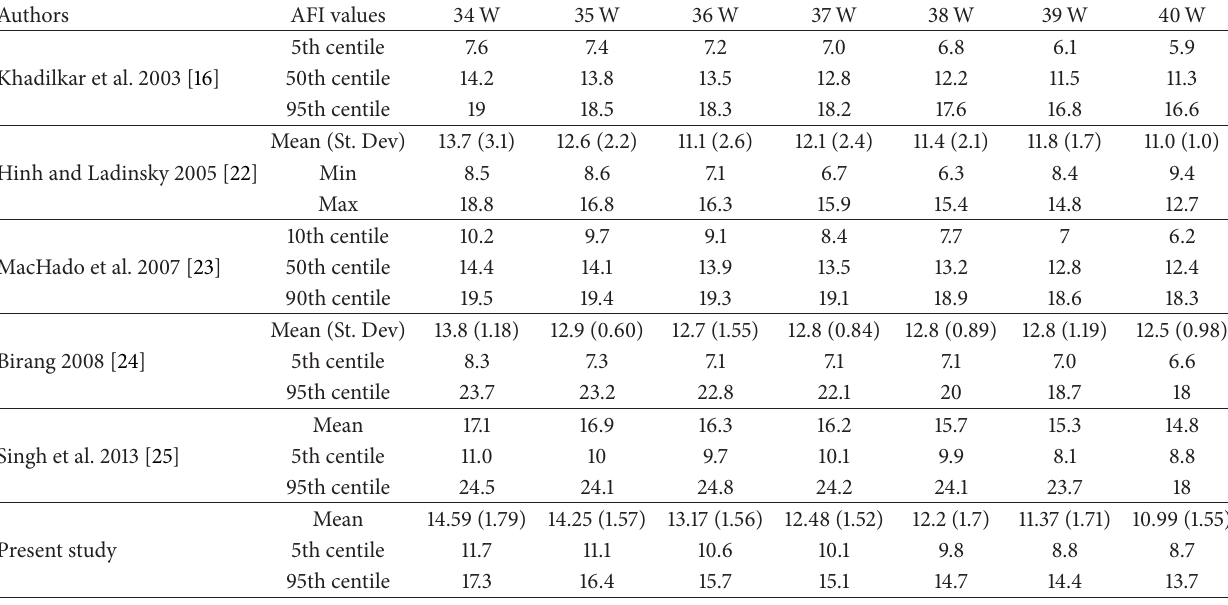
Table 4: Values of AFI (in cm) by different authors.